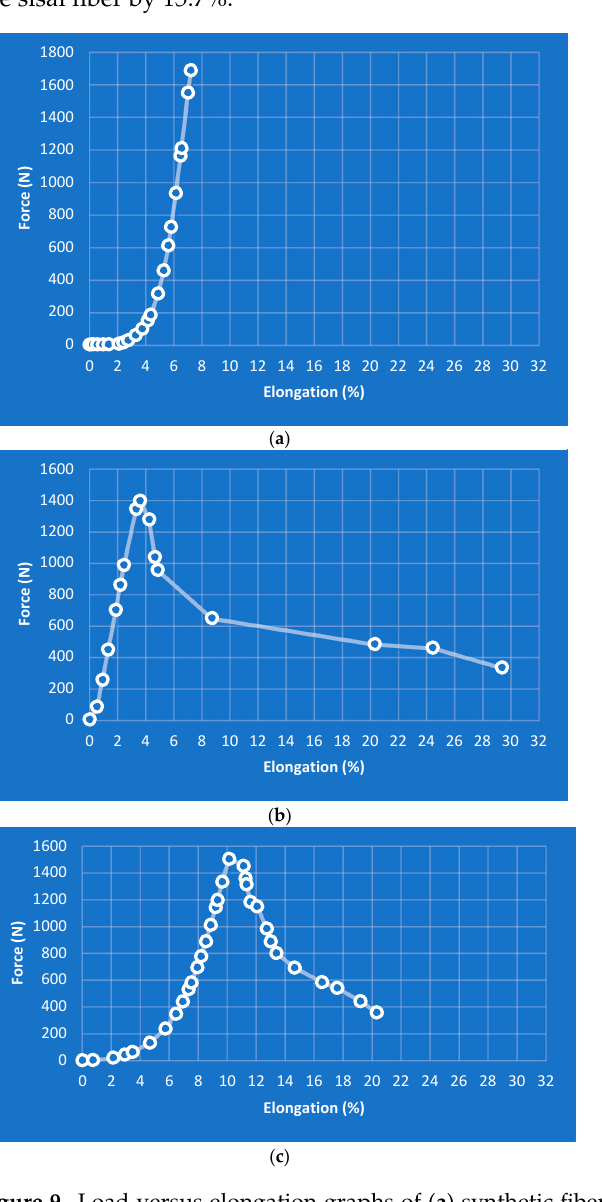
Figure 9. Load versus elongation graphs of ( a ) synthetic fiber; ( b ) sisal fiber—uncoated; ( c ) sisal fiber—coated with zinc oxide.